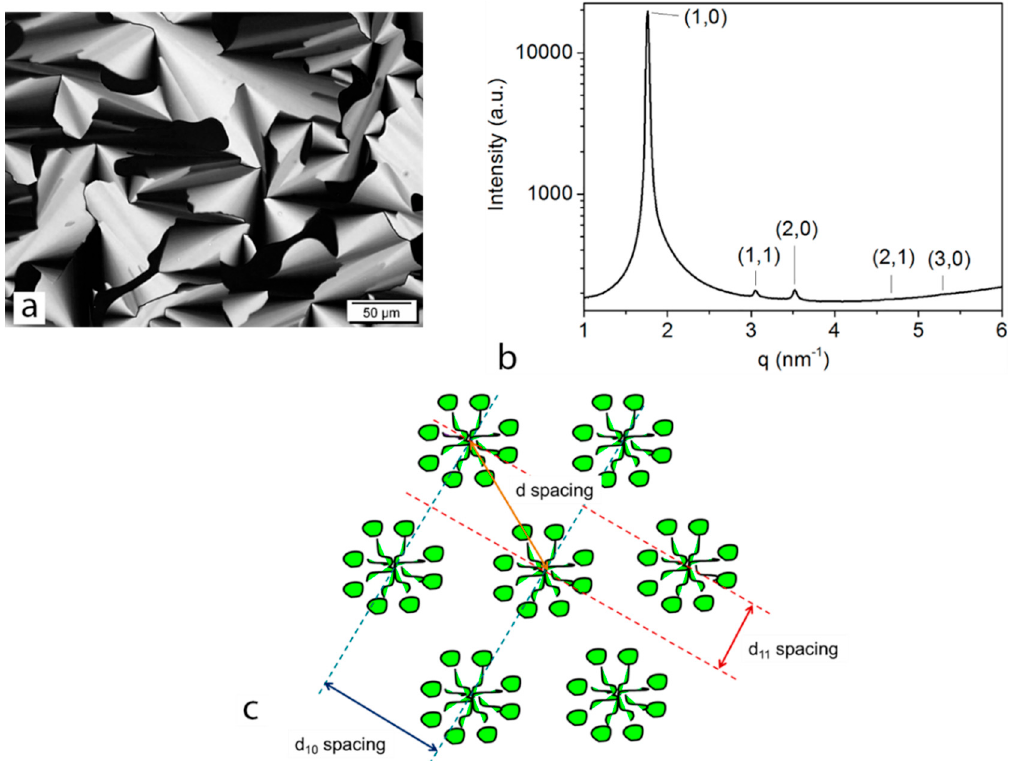
Figure 2. Hexagonal LLC phase formed using DTAB: ( a ) Polarized light microscopy image of the hexagonal phase; ( b ) SAXS profile of the hexagonal phase and indexing of each peak according to the hexagonal lattice; and ( c ) a schematic of the hexagonal phase including the origin of the important Bragg peaks.